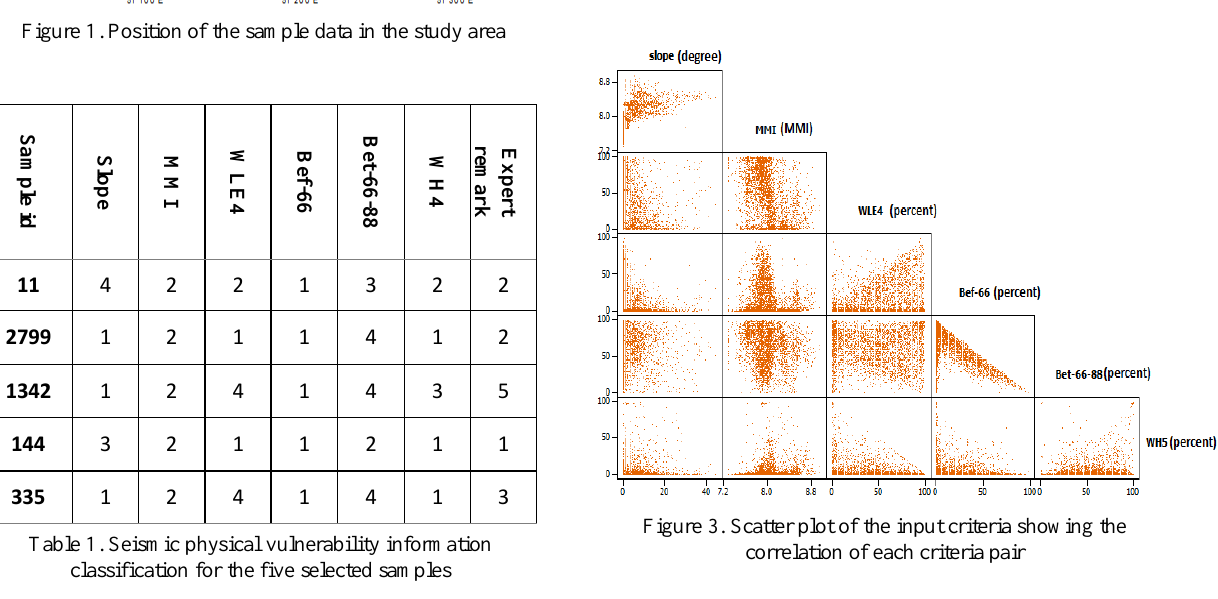
Figure 2: Proposed methodology